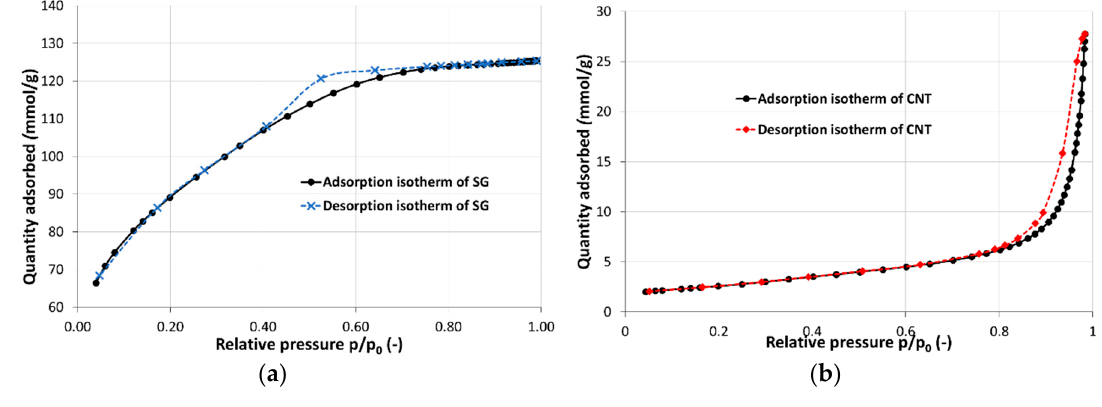
Figure 2. N 2 sorption isotherms of ( a ) SG and ( b ) CNTs.